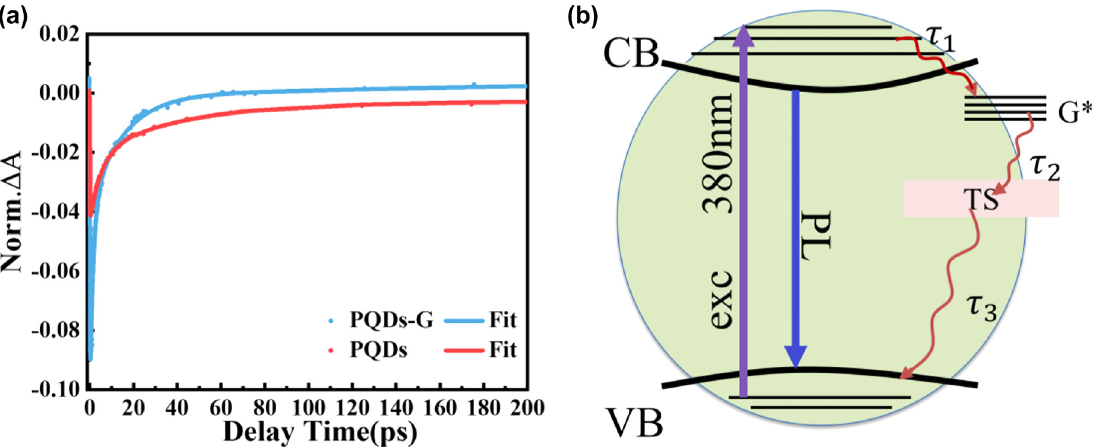
Figure 8: (a) TA decay kinetics (dotted lines) with triple exponential fitting curves (solid line) of PQDs (red) and PQDs-G (blue) under 380 nm excitation. (b) Schematic representation of the proposed charge transfer model in PQDs-G.